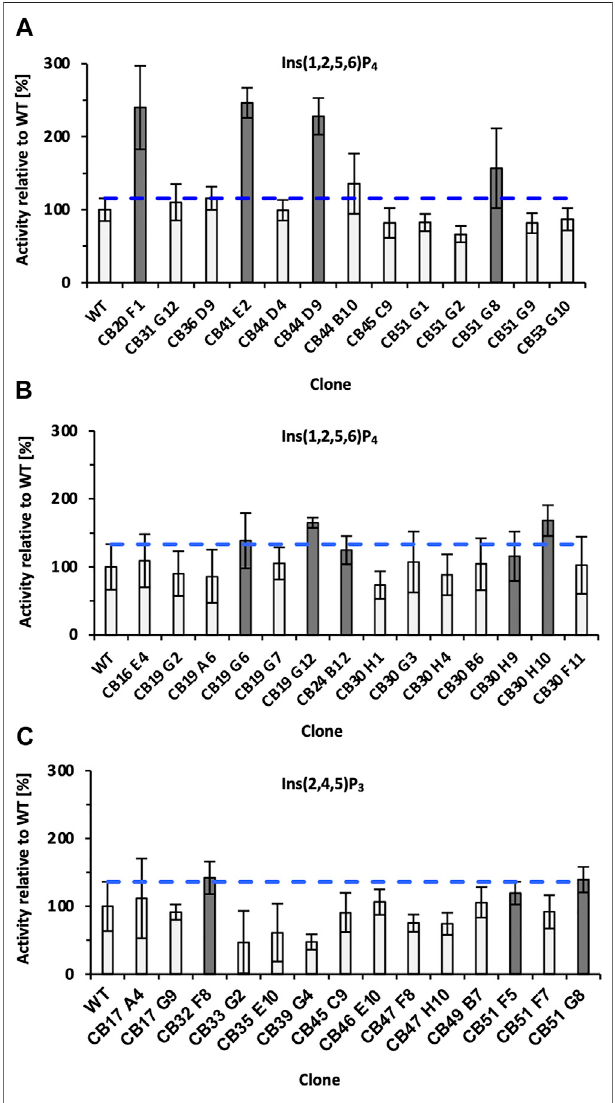
FIGURE 3 | Final rescreening results of improved variants obtained from epPCR libraries. Relative improvements were determined for the substrates Ins(1,2,5,6)P 4 (A,B) and Ins(2,4,5)P 3 (C) . Only variant CB51 G8 showed promising activities for both substrates and was consequently selected for rescreening twice (A,C) . The blue dotted line represents the threshold for classifying clones as improved. Clones marked dark gray were sent for sequencing and additionally expressed in a 50 ml shake fl ask to determine protein adjusted improvements. Signi fi cantly improved refers to the relative activity of the variant minus SD, surpassing the relative activity of WT plus SD. WT, wild type; SD, standard deviation.